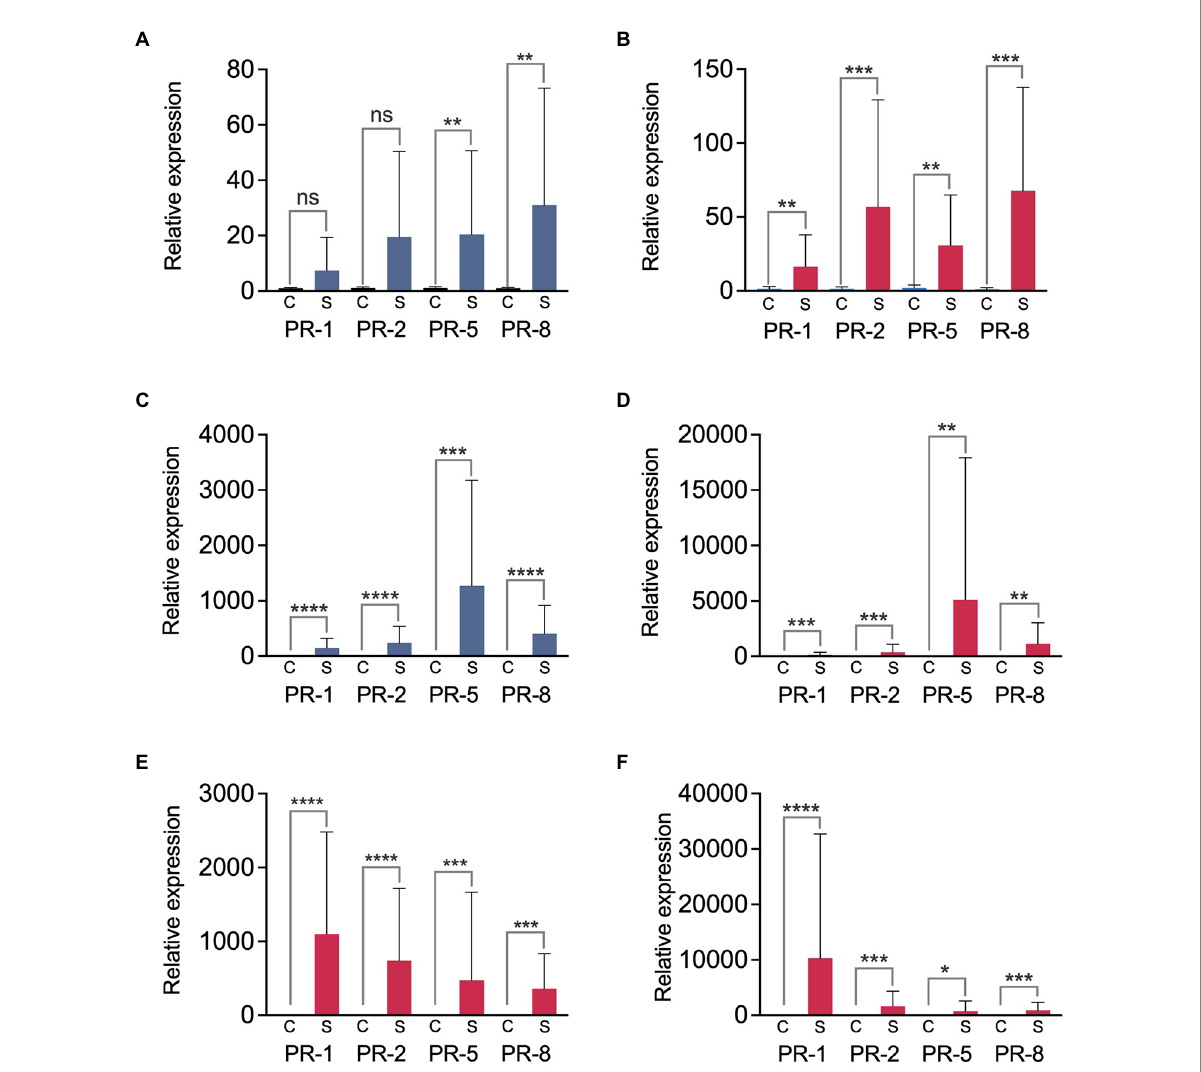
FIGURE 9 Relative expression of PR genes in the bark surrounding fire blight cankers. We analyzed bark samples from the fire blight highly susceptible and moderately susceptible apple cultivars ‘Cortland’ (A,B) and ‘Honeycrisp’ (C,D) , respectively, and from the Asian pear cultivars ‘Hosui’ (extremely susceptible) (E) and ‘Shinko’ (highly susceptible) (F) . Blue (A,C) and red columns (B,D–F) show the results obtained with cankers from irrigated and non-irrigated trees, respectively. Bars represent average relative expression values from two independent experiments, calculated by the 2 - ΔΔ Ct method, using actin gene as a calibrator. The error bars represent standard deviation (SD). Asterisks indicate significant differences between the relative expression of the indicated PR gene in the control (C) and in the bark samples near canker (S), assessed by two-tailed unpaired t -tests, * p < 0.05; ** p < 0.01; *** p < 0.001; **** p < 0.0001; ns, not significant ( p >